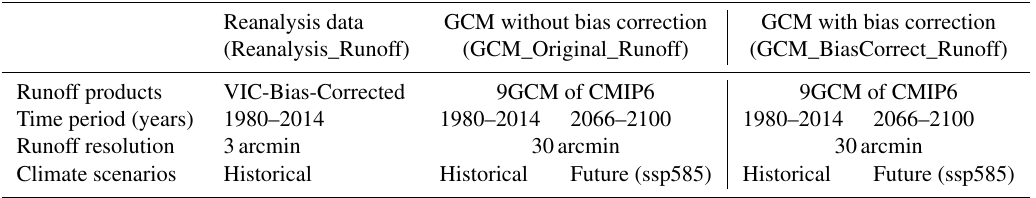
Table 1. Runoff products used in this